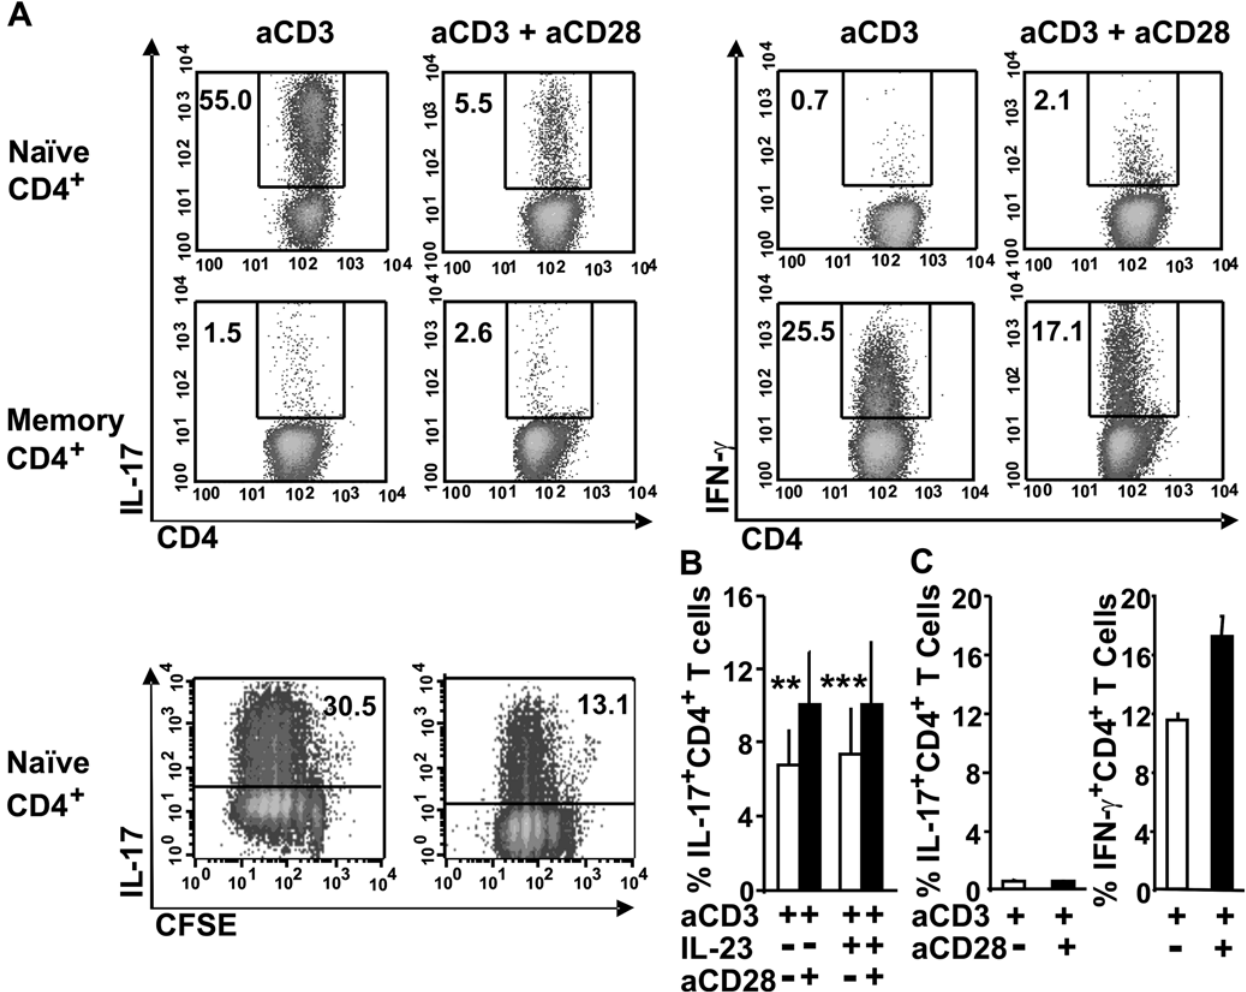
Figure 2. CD28 co-stimulation did not modulate memory Th17 cells. (A) FACS sorted naı¨ve CD4 + (CD4 + CD62L high CD44 low ), CFSE-labeled naı¨ve CD4 + CD25 2 (CD4 + CD62L high CD44 low CD25 2 ) and memory CD4 + (CD4 + CD62L low CD44 high ) T cells were cultured with anti-CD3 in the presence or absence of anti-CD28 mAb under pro-Th17 conditions for 4–5 days. Shown is one representative experiment out of at least three. ( B ) CD4 + T cells were stimulated with anti-CD3 under Th17 polarizing conditions for 4–5 days and restimulated with plate-bound anti-CD3 in the presence or absence of IL-23, and with or without anti-CD28 mAb for 2 days. Data represent the mean 6 SD of five to seven independent experiments. ( C) Purified CD4 + T cells were cultured with anti-CD3 in the presence or absence of anti-CD28 mAb without adding Th17 differentiation cytokines for 4–5 days. Data are the mean 6 SD of 2 independent experiments. (A–C) Cells were restimulated for 6 h with PMA/Ionomycin in the presence of brefeldin A. Naı¨ve and memory CD4 + T cells were stained intracellularly for IL-17 and IFN- c and CFSE-labeled naı¨ve CD4 + CD25 2 for Il-17. Numbers represent the percentage of positive cells in each gate. P value were calculated using the two-tailed, paired Student’s t test, **, P , 0.01; ***, P , 0.001.